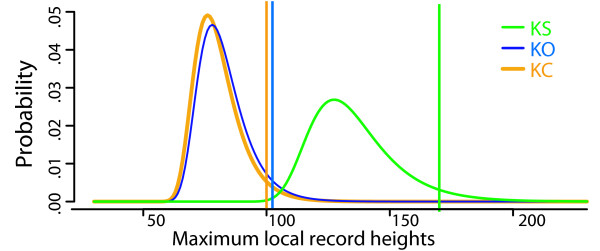
Statistical justification of threshold values - 100, 100, and 170 for topologies KO, KC, and KS, respectively - used to identify recombination events. Values on the x-axis are maximal local scores. EVD probability densities for the maximum maximal local score attained by random walks of length M' appear as bell-shaped curves with a pronounced skew to the right. Threshold values, demarcated by vertical lines, correspond to conservative significance levels (α = 0.05) for these distributions.